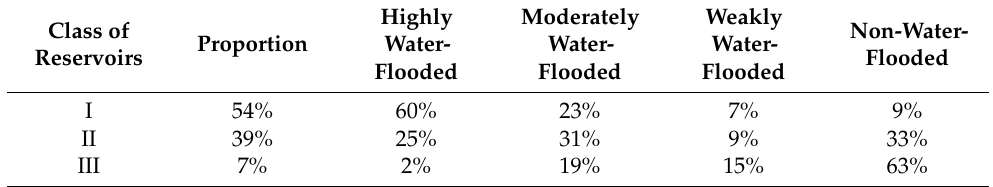
Table 5. Water-flooded zones in classified reservoirs in P Formation, Kalamkas Oilfield.